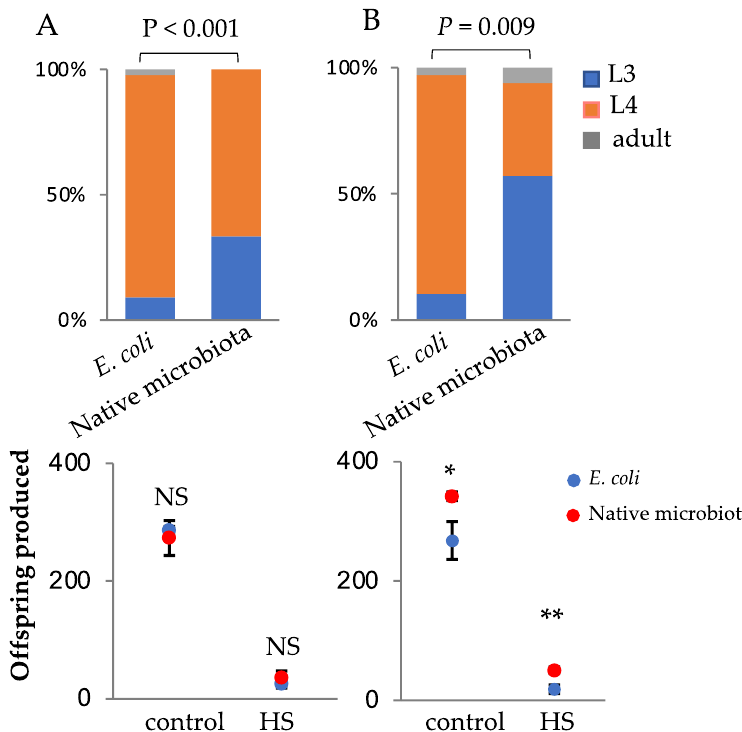
Figure 3. Support for an inverse relationship between accelerated development and heat stress resistance. Shown are two instances ( A , B ) where worms raised on complex microbiotas showed slower development than those raised in E. coli -only microcosms. Top, developmental stages after 43 h (20 ◦ C); Fisher exact test. Bottom, fecundity with or without heat stress (HS, 31 ◦ C for 6 h). Error bars represent ± standard error of the mean. * p < 0.05, ** p < 0.01, t -tests. Fecundity data was obtained from worms exposed to heat stress at the L4 stage. n = 20 worms per treatment in each soil type.